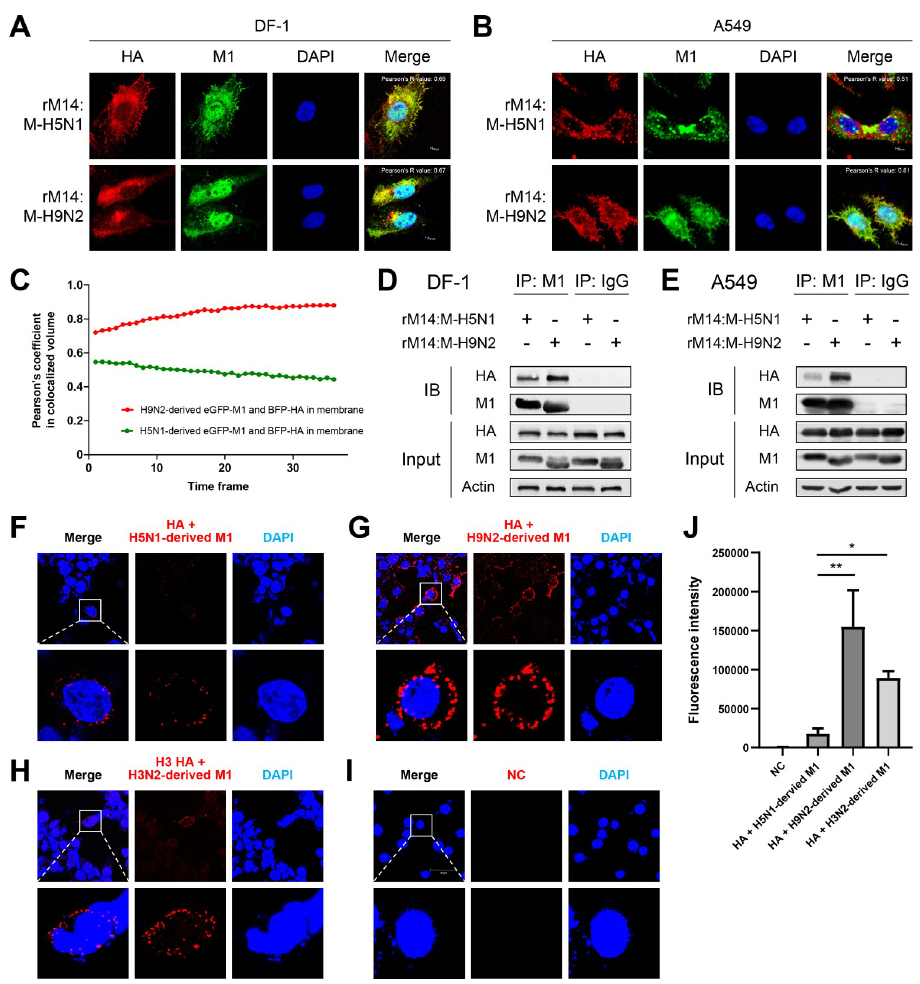
Fig 3. H9N2 virus-derived M1 protein strongly bound HA protein in mammalian cells. (A-B) DF-1 or A549 cells were infected with rM14:M-H5N1 or rM14:M-H9N2 viruses at an MOI of 1. Confocal microscopy was performed to detect H5N6 HA and M1 protein localization in cells (green and red fluorescence resulting in a yellow color denote colocalization). (C) The dynamic colocalization 24 h post-transfection as observed via live imaging of H9N2 virus- derived eGFP-M1/BFP-HA or H5N1-derived eGFP-M1/BFP-HA transfected A549 cells. Pearson’s coefficients were analyzed in co-localized volume between eGFP-M1 and BFP-HA located at the membrane in 36-time frames (1-time frame duration = 42.62 s). (D–E) Physical interaction of viral M1 and HA proteins in cells. (D) DF-1 or (E) A549 cells separately infected with rM14:M-H5N1 and rM14:M-H9N2 viruses at an MOI of 1. At 24 hpi, cell lysates were immunoprecipitated using anti-M1 antibody or anti-IgG antibody, followed by Western blotting for influenza M1 and HA proteins. In A549 cells, an increased binding ability was observed between H9N2-derived M1 and HA proteins than between H5N1-derived M1 and HA proteins. IB, immunoblot. (F–H) interaction between influenza HA and M1 protein was determined by proximity ligation assay. 293T cells were co-transfected with (F) H5 HA and H5N1-derived M1 , (G) H5 HA and H9N2-derived M1 , (H) H3 HA and H3N2-derived M1 , or (I) empty vector as negative control (NC). 24 h post transfection, PLA was performed using antibodies specific to influenza M1 and HA proteins. Fluorescence of cells was analyzed by a fluorescence confocal microscope (red fluorescent signal). Nuclei were stained with DAPI (blue). (J) Multiple images (F–I) were processed by BlobFinder software to measure the PLA fluorescence intensity (~30 cells total for each condition). Graphs show the means ± SD of three independent experiments ( � , P < 0.05; �� , P <